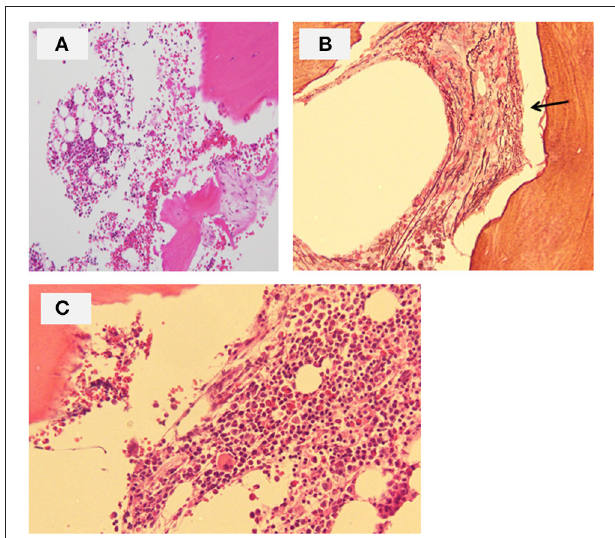
FIGURE 1 | Bone marrow biopsy of the patient. (A) Hematoxylin and eosin section at onset showing a hypocellular marrow with trilineage hypoplasia (original magnification × 40). (B) Silver staining section at onset showing increased diffuse coarse reticulin (arrow) (original magnification × 100). (C) Hematoxylin and eosin section following pharmacological treatment for hyperparathyroidism showing normal trilineage hematopoiesis and complete reversal of fibrosis (original magnification ×